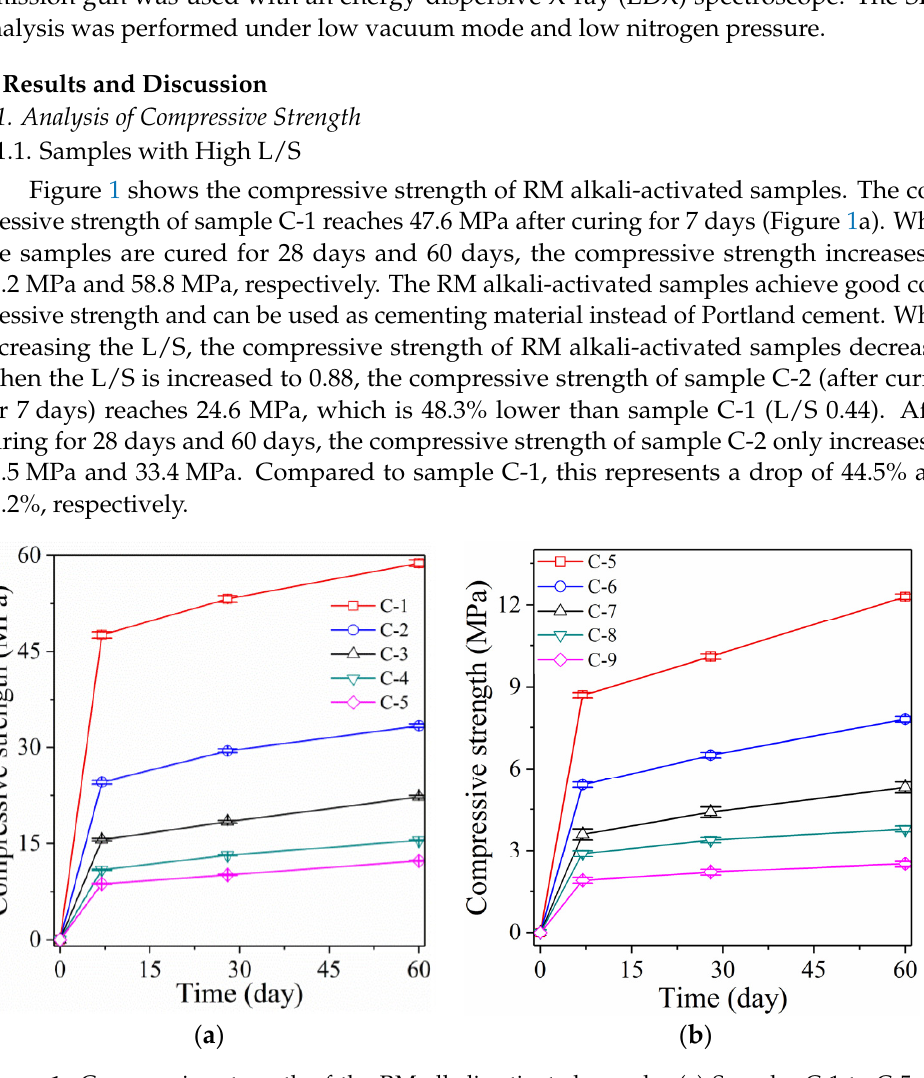
Figure 1. Compressive strength of the RM alkali-activated samples ( a ) Samples C-1 to C-5 and ( b ) Samples C-5 to C-9.